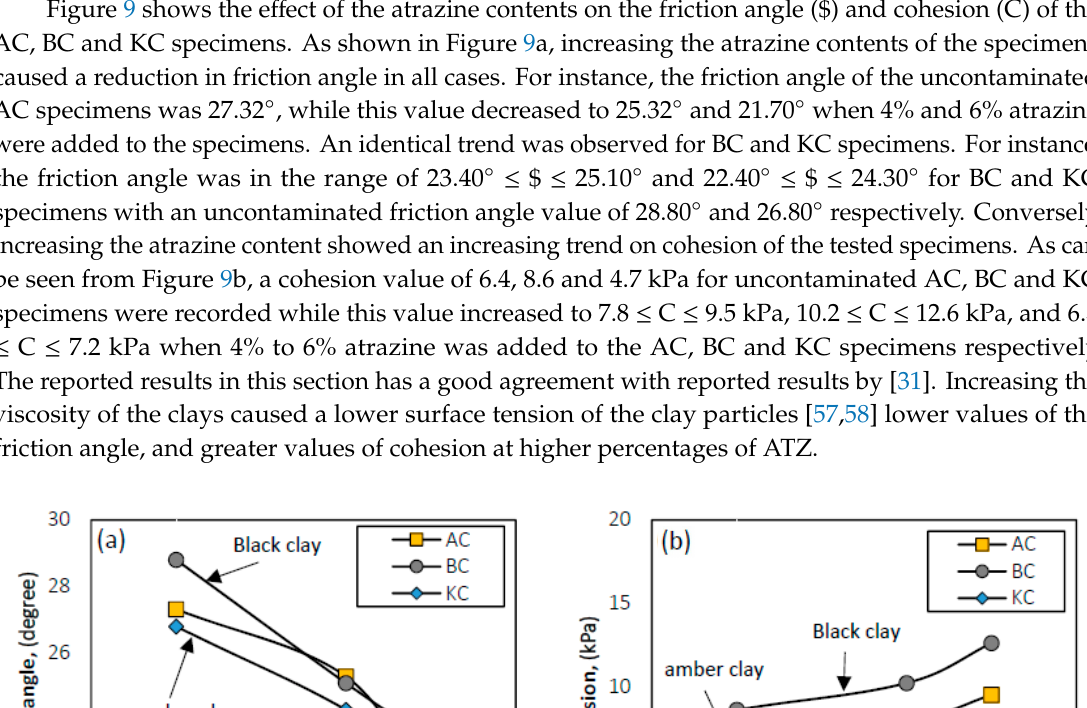
Figure 8. Ring shear test results for AC, BC and KC specimens under 200 kPa normal stress for (a) peak shear stress versus atrazine content; (b) Residual stress ratio versus atrazine content.